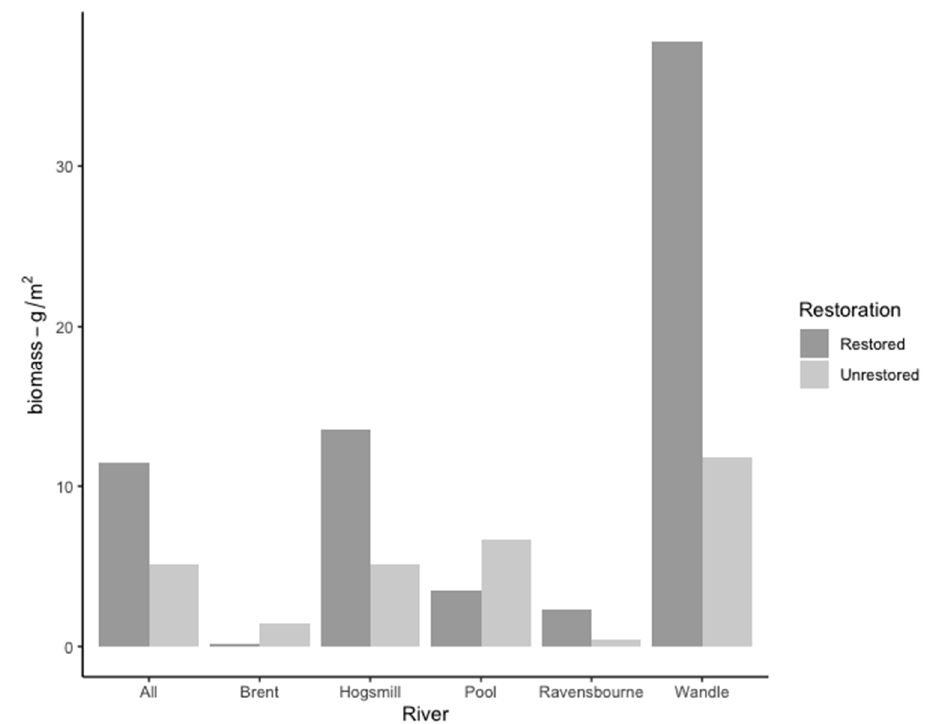
Figure 3. All fish biomass (g/m 2 ) for all sites, separated by river and reach. The data displayed in the “All” column shows the sum of all fish biomass caught across the total area sampled in the restored and unrestored study reaches.